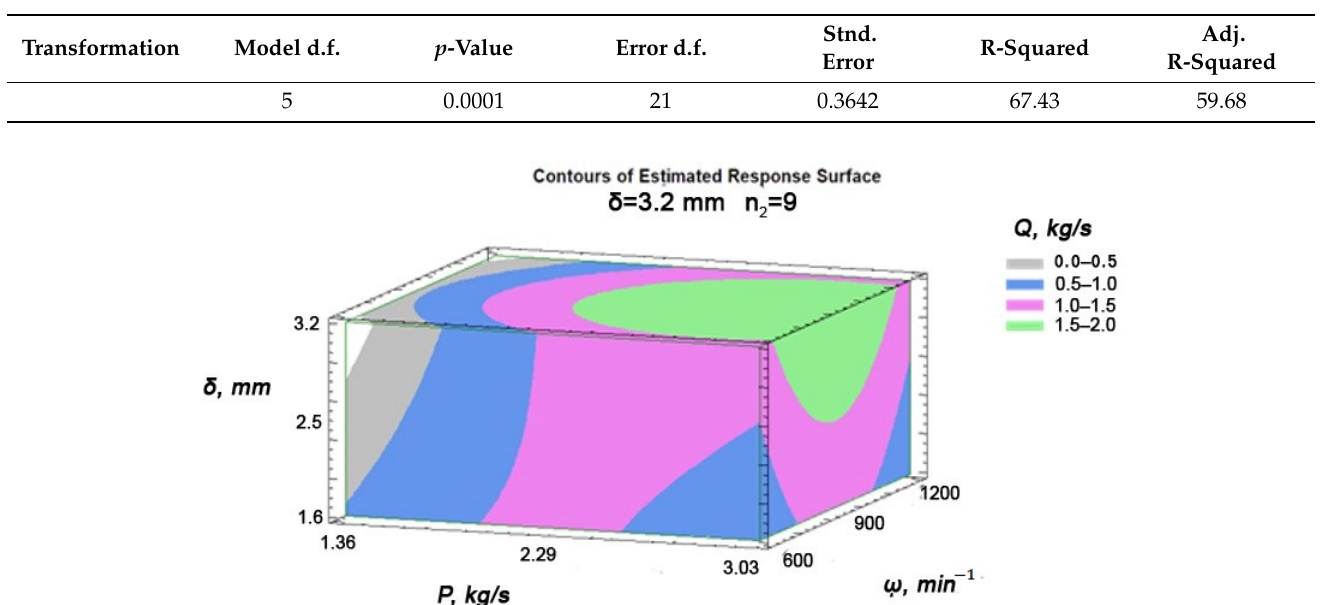
Figure 5. Three-dimensional graph of the response surfaces of the performance of the shredder Q at a fixed value of the number of knives at the second stage ( n 2 = 9) (own study).